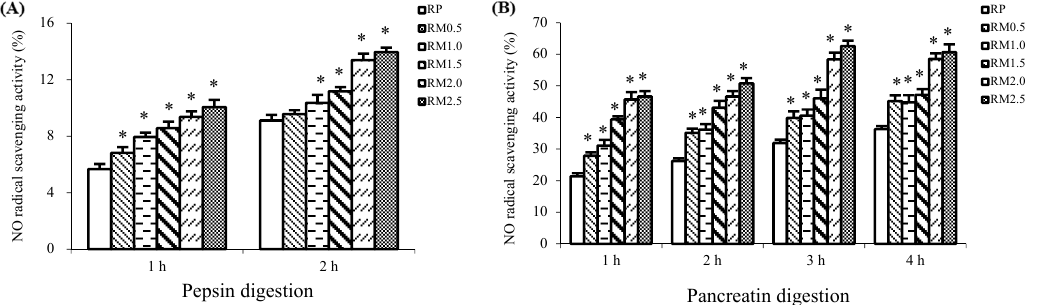
Figure 3. Nitric oxide (NO) radical scavenging activities of rice protein (RP) and methionine added to rice protein (RM) hydrolysates during in vitro digestion with pepsin ( A ) and pancreatin ( B ). Values are the means ± SEM ( n = 3). * p < 0.05, in comparison with RP.